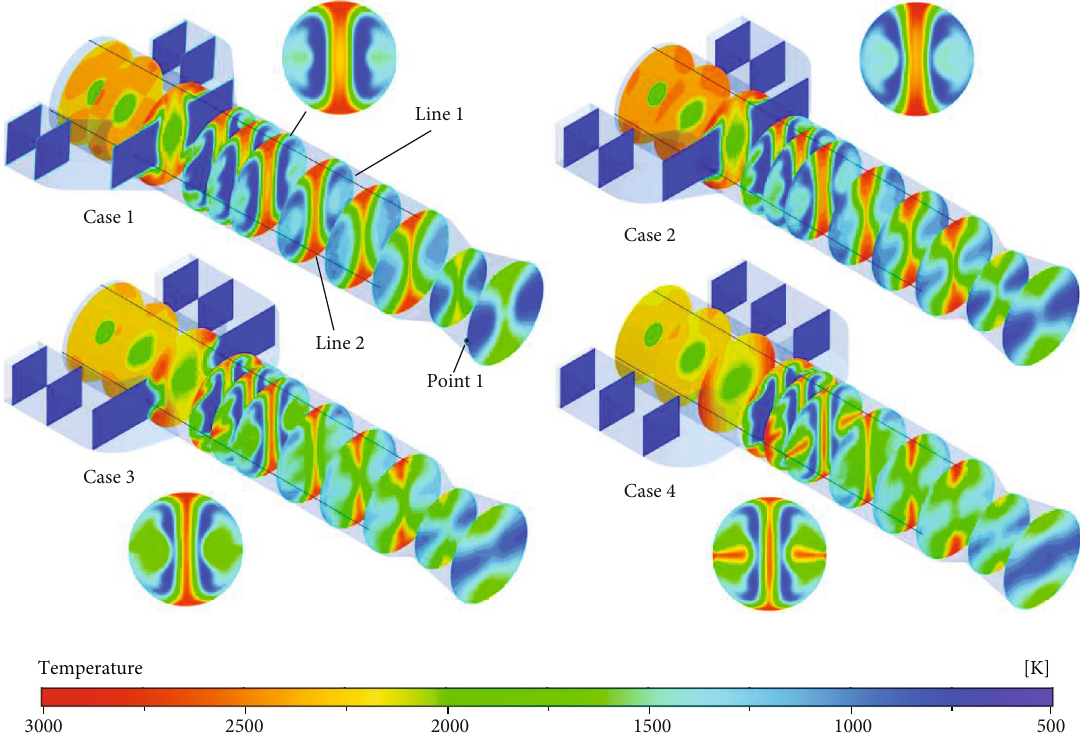
Figure 5: Temperature distributions in each cross section of the afterburners, shown individually in the cross section of x = 400 mm .